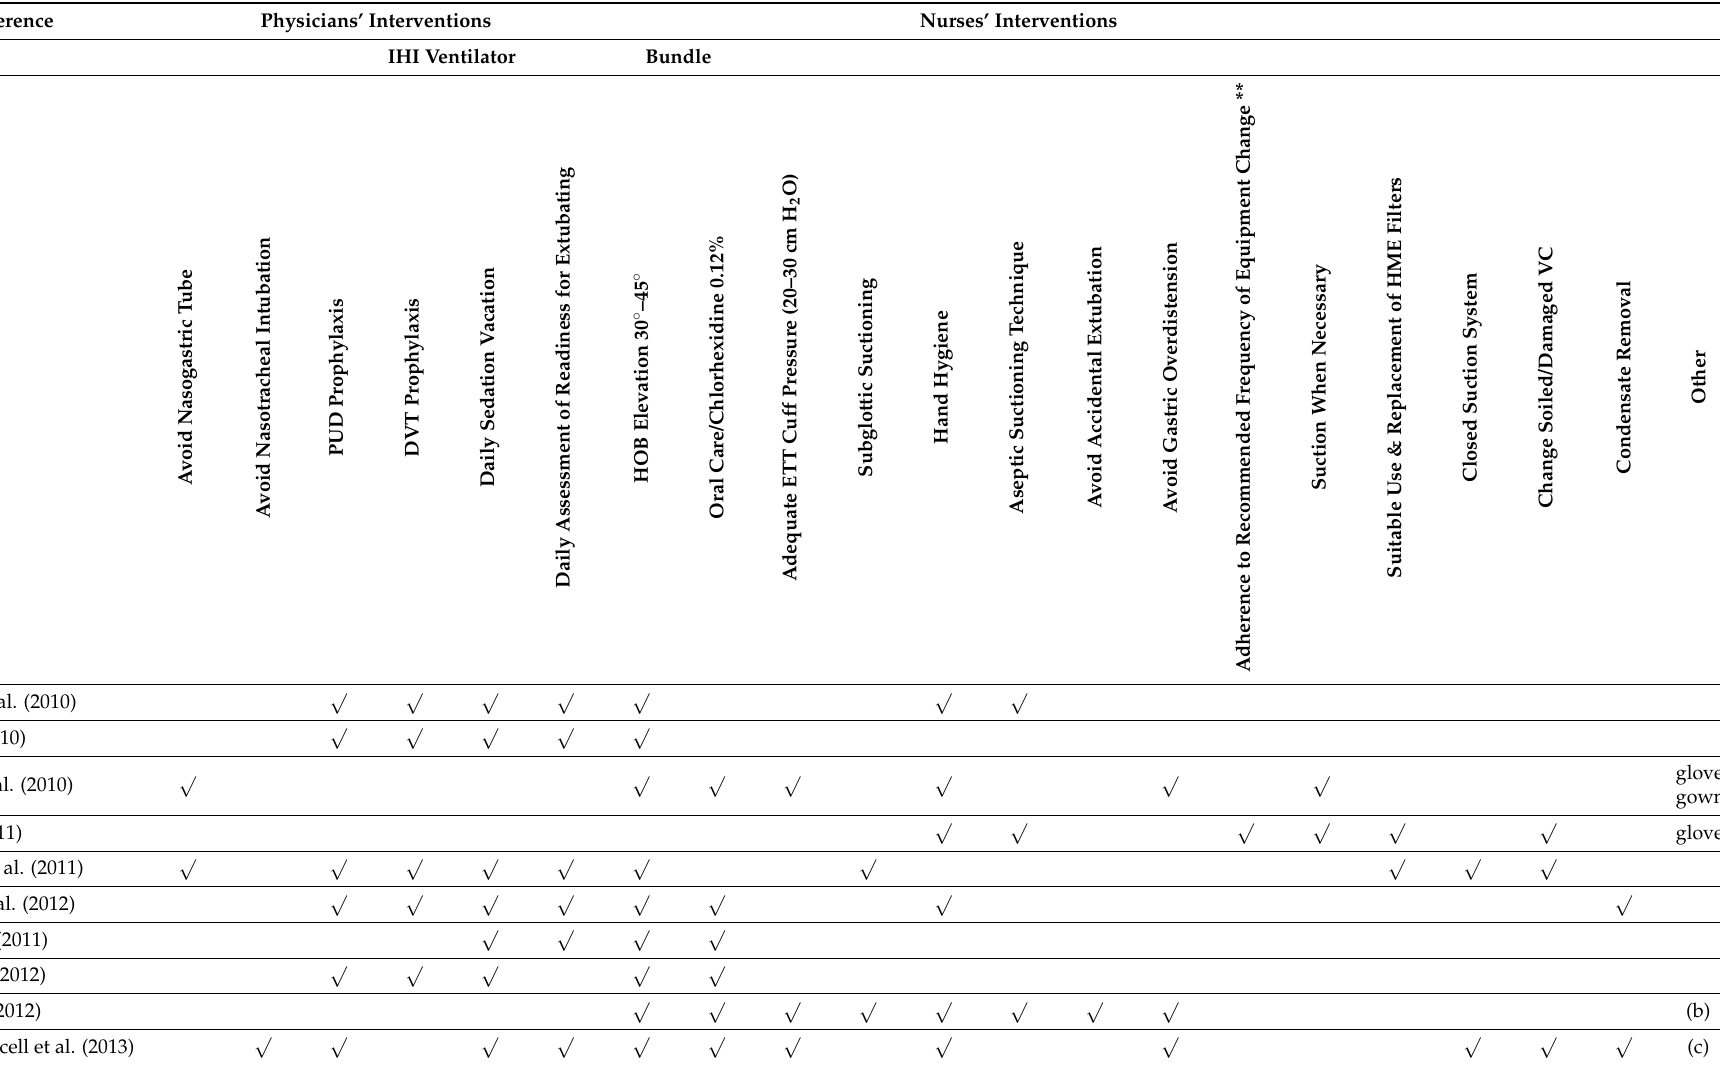
Table 2. Preventive VAP measures monitored in revised